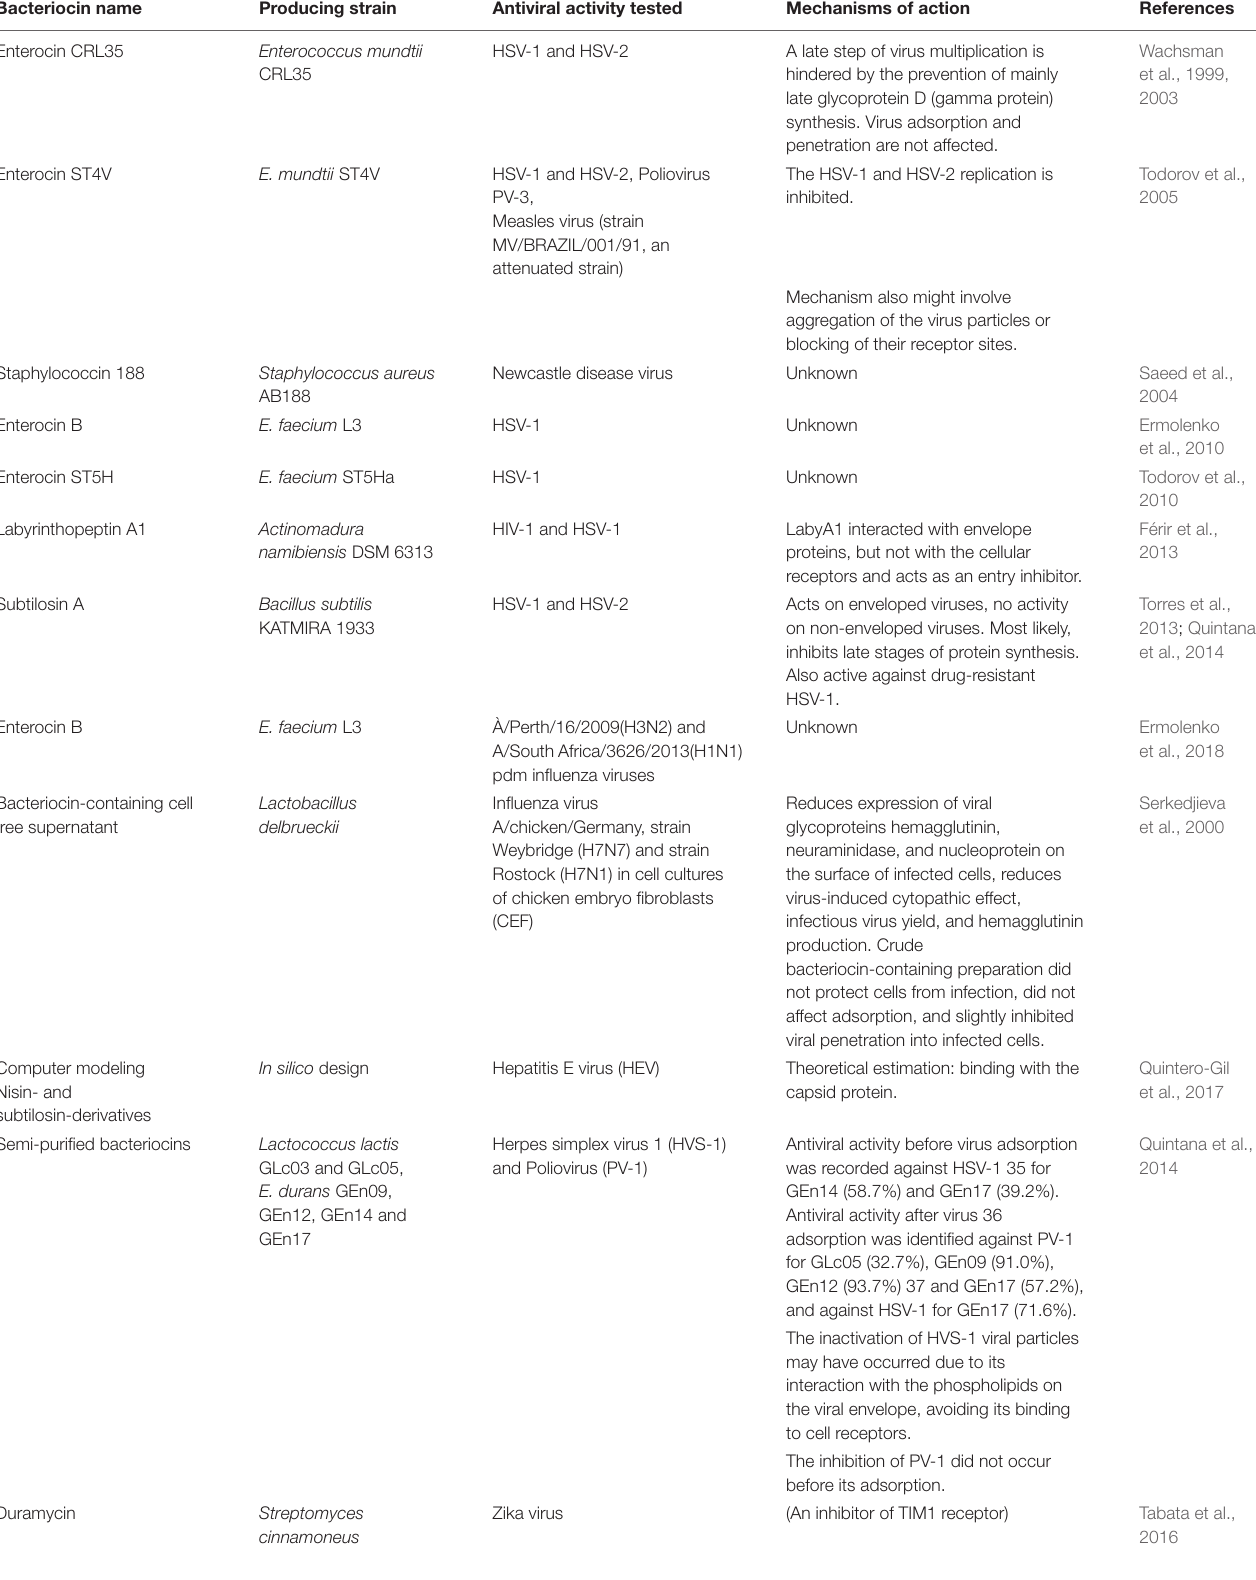
TABLE 2 | Anti-viral activity of